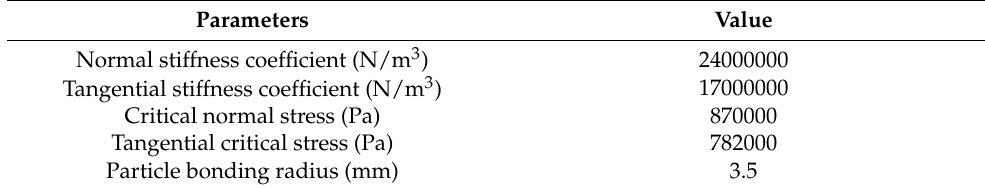
Table 3. Comparison of soil compactness.